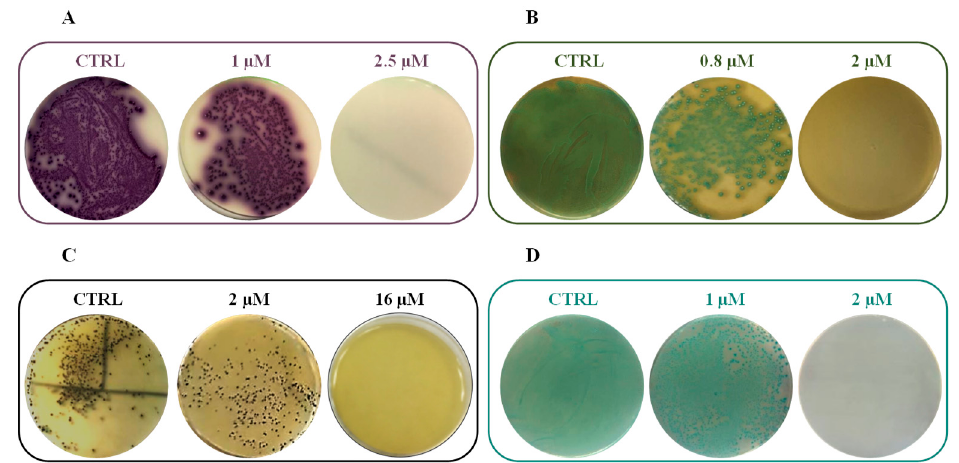
Figure 6. Antibacterial activity of RiLK1 against di ff erent foodborne pathogens: ( A ) S. Typhimurium, ( B ) L. monocytogenes , ( C ) S. aureus , and ( D ) E. coli . CTRL: each tested pathogen without treatment. Bacterial cultures treated, or not, with di ff erent concentrations of peptides were seeded on selective plates. The photographs are representative of three independent experiments performed in triplicate.